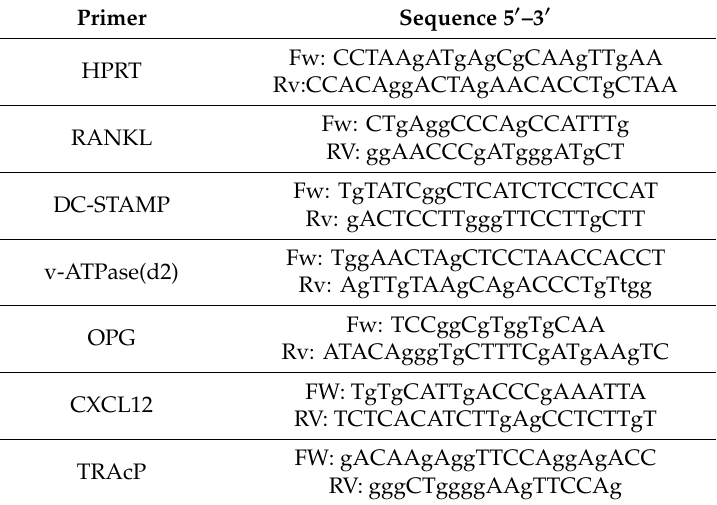
Table 1. Primers used for Quantitative